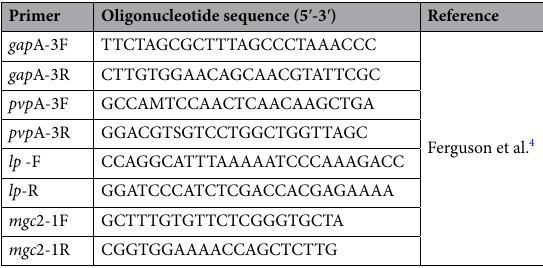
Table 1. MG PCR Primers for MG